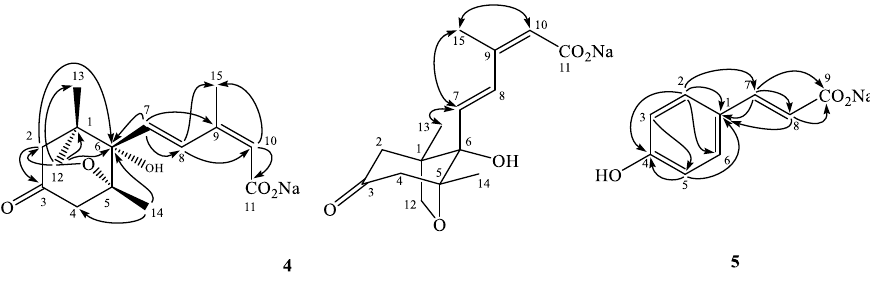
Figure 3. Key HMBC ( → ) and NOESY ( ↔ ) correlations of 4 and 5 .